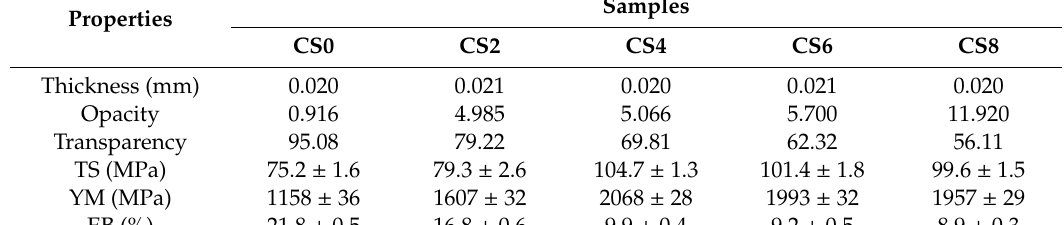
Table 2. Physical properties of the samples.